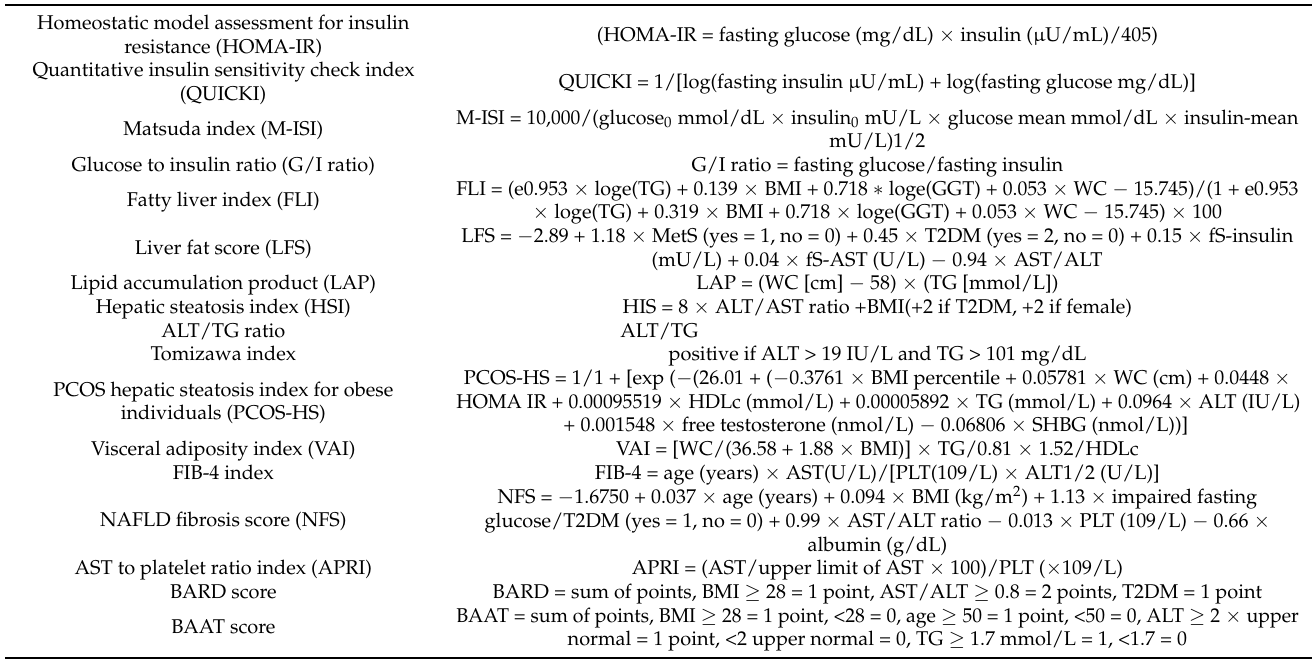
Table 1. Insulin resistance, steatosis, and fibrosis indices used in the study. Homeostatic model assessment for insulin resistance (HOMA-IR) Quantitative insulin sensitivity check index